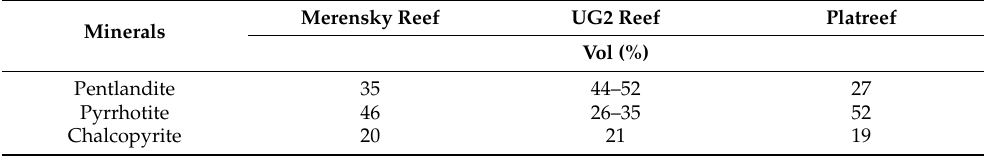
Table 3. Mineralisation of the Merensky, UG2 and Platreef ores with respect to base metal sulphides [25].